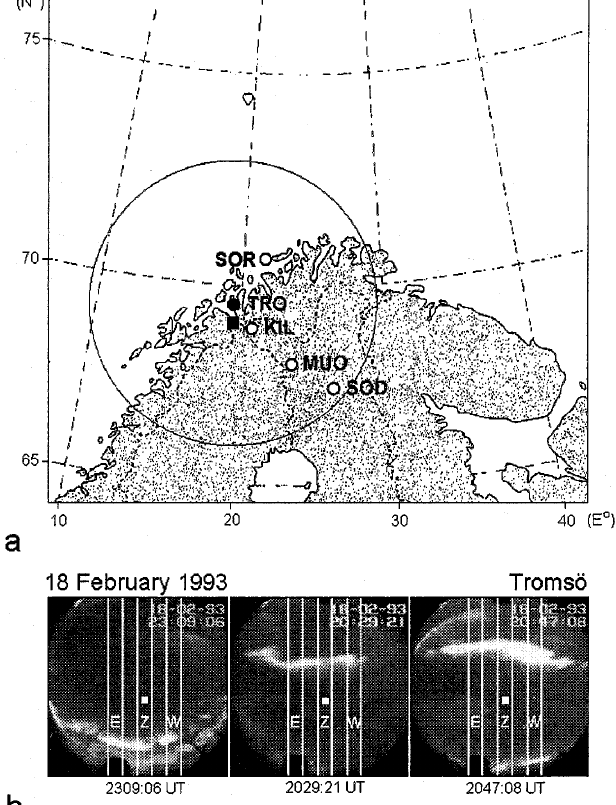
Fig. 1. a Map showing the location of the EISCAT transmitter and TV-camera ( black circle ), as well as magnetic stations ( open circles ); the large circle indicates the field of view of the TV-camera, the black square shows the EISCAT zenith at an auroral height of 100 km. b TV-images showing the co-location of the auroral arcs and the EISCAT zenith marked with white